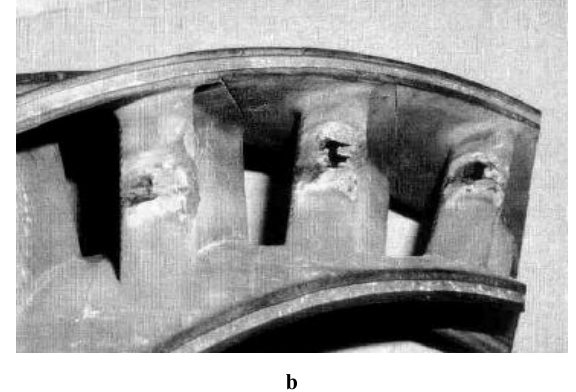
Fig 5. Blade after 8000 hours operating time (a) and inlet vanes sectors after 12000 hours operating time (b)